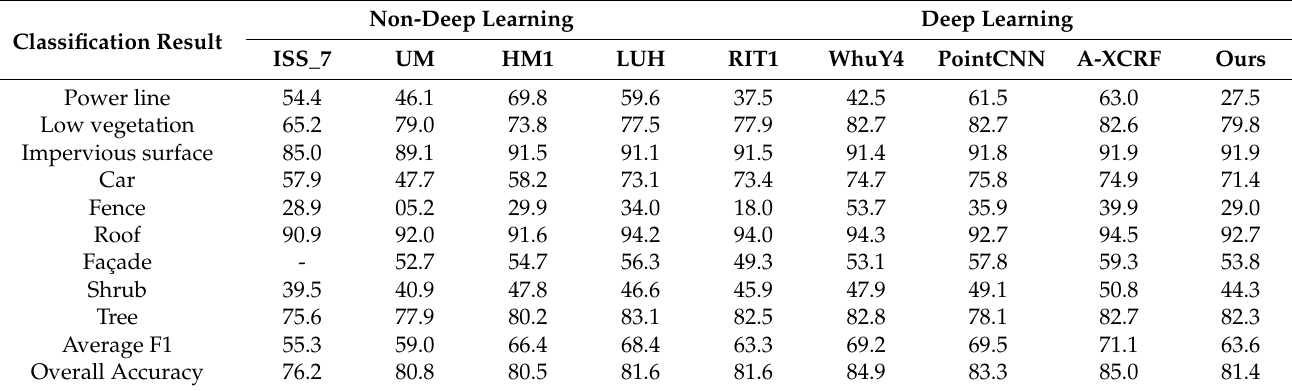
Table 3. Comparison of fusion-level strategy results with other